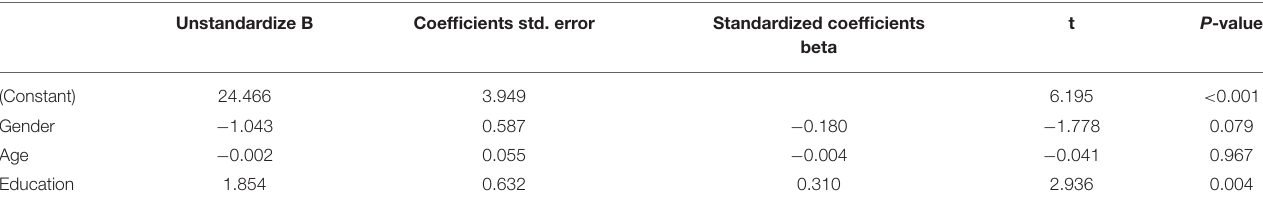
TABLE 3 | Results of multiple linear regression analysis of gender, age, and education on BNT-C